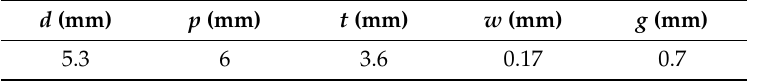
Table 3. Geometric parameters of each unit cell in the designed OTMMA in Figure